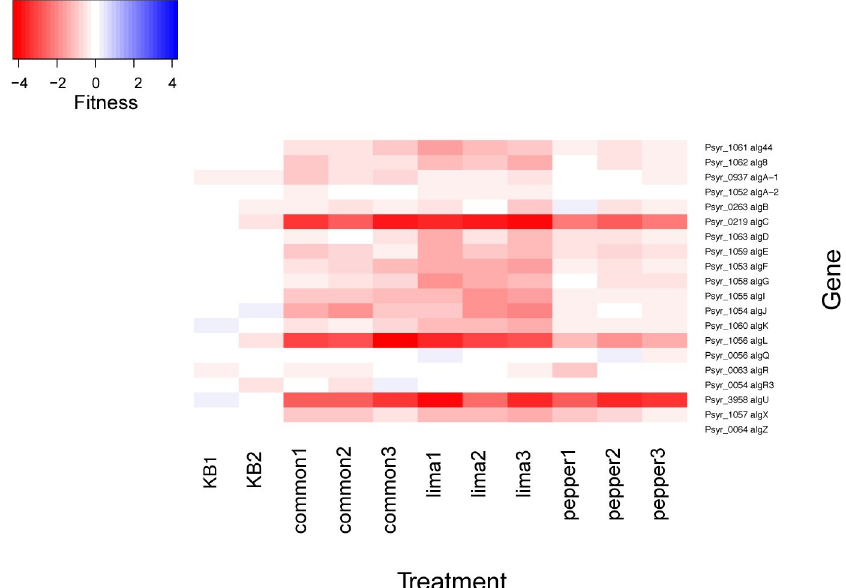
Fig 6. Apoplastic fitness values for alginate biosynthetic genes. Genes alg44 , alg8 , algA-1 , algF , algI , and algK had significantly different fitness values in the 3 plant species by a Kruskal-Wallis test (p < 0.05).